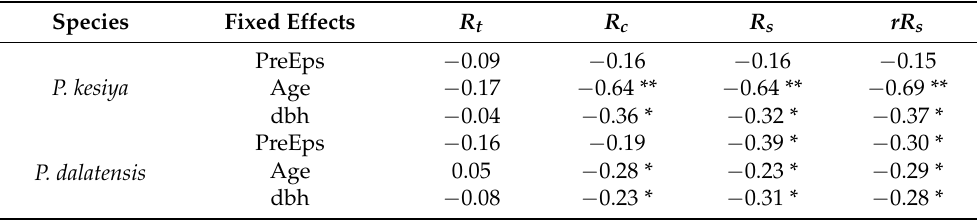
Table 3. Correlation coefficients of parameters for fixed effects in a linear model relating sensitivity indicators of P. kesiya ( n = 32) and P. dalatensis ( n = 103) to pre-stress (PreEps) growth, diameter at breast height of stress episodes (dbh) and tree age (Age). The significance of the fixed effects is indicated with * for p < 0.05 and ** for p < 0.01.